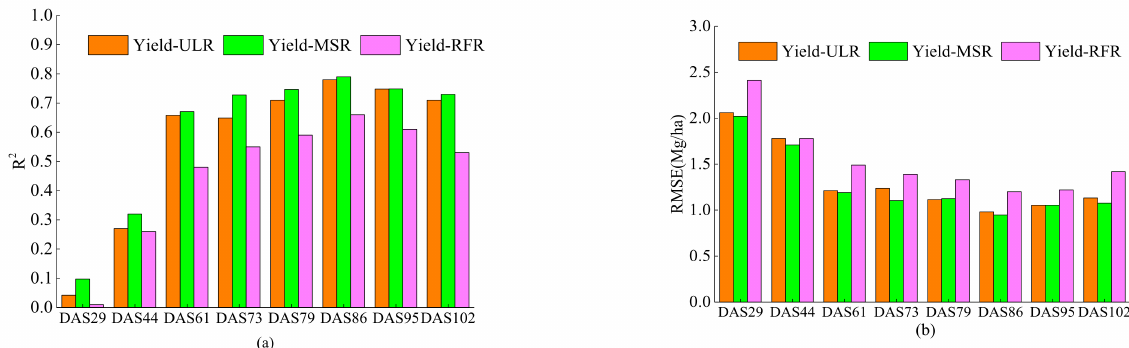
Figure 3. Model validation in each growth stage based on PlanetScope images. ( a ) R 2 and ( b ) RMSE.